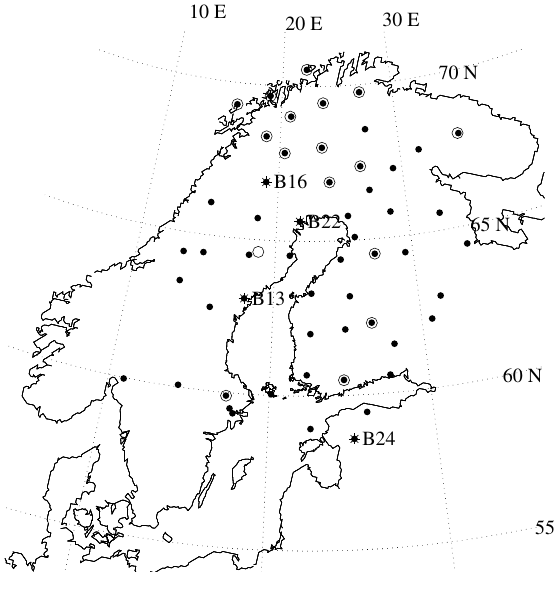
Fig. 1. BEAR sites in summer 1998. IMAGE magnetometer stations operating at that time are marked with circles (Svalbard excluded). The four stations B13, B16, B22, B24 used in Fig. 5 are assigned by their codes.